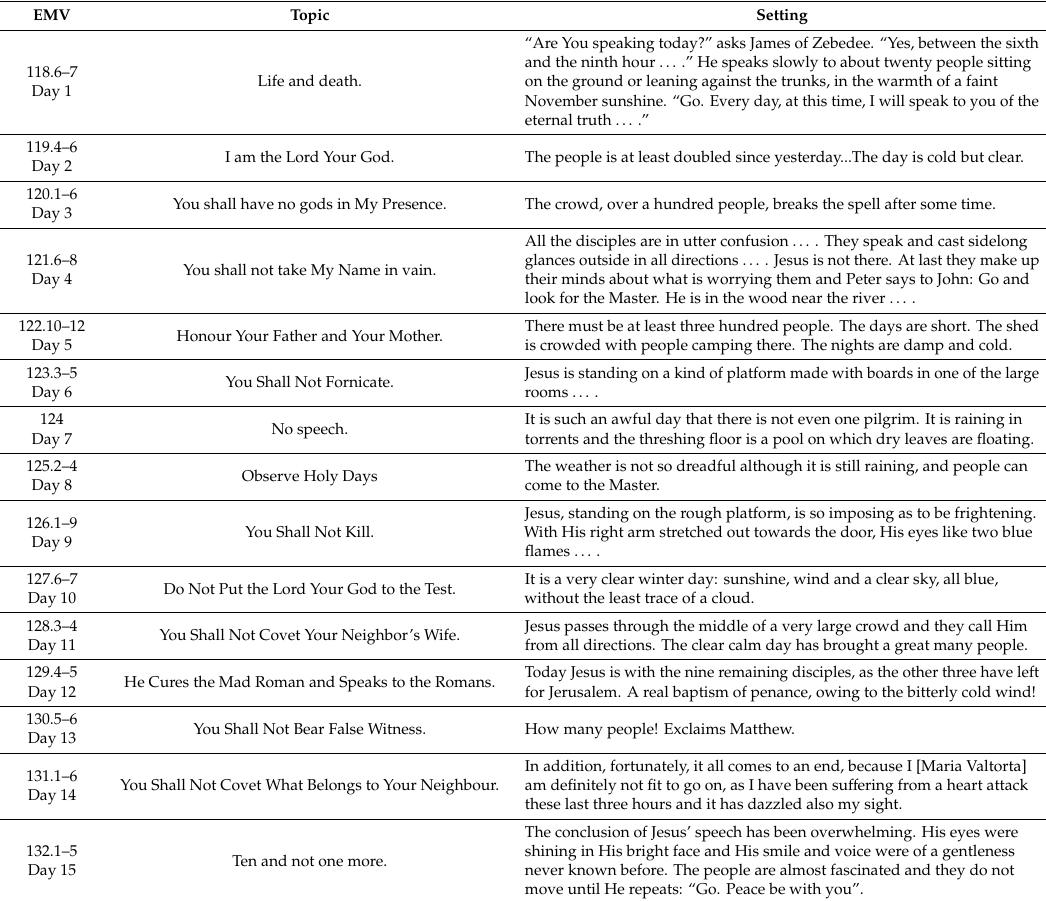
Table 3. Date, topic and setting of the speeches delivered at the Clear Water (14 episodes).